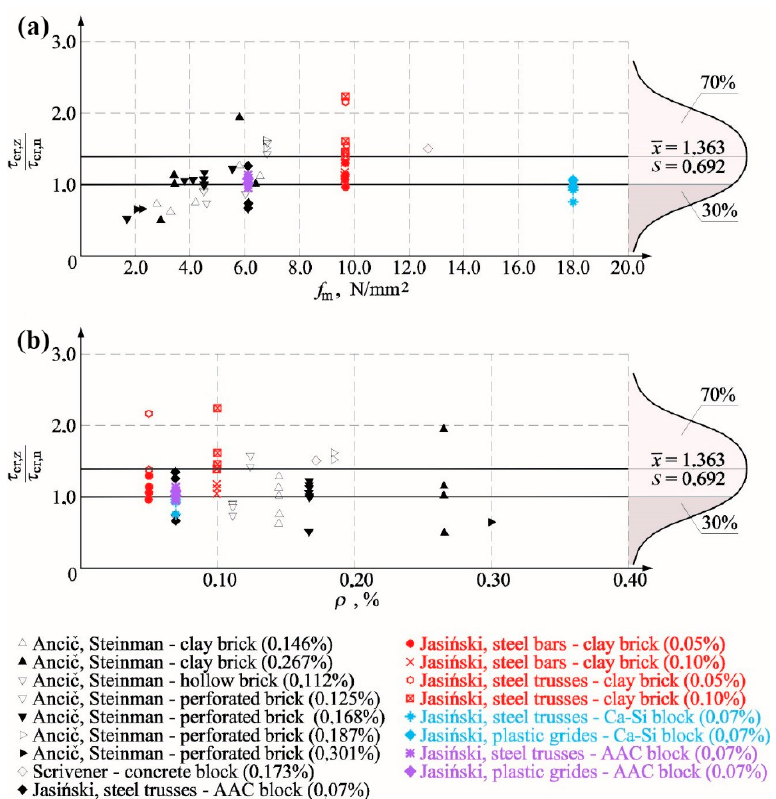
Figure 17. Summary of test results: ( a ) cracking stress value for reinforced wall τ cr,z / cracking shear stress value for unreinforced wall τ cr,n —depending on the percentage of horizontal reinforcement ρ —and ( b ) ratio τ cr,z / τ cr,n — compressive strength of mortar f m.